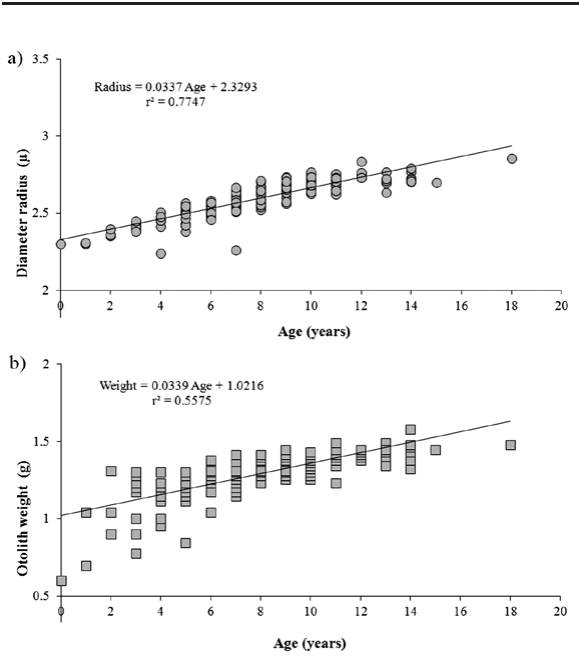
Fig. 5. – Relationships between the age and diameter (a) and weight (b) of otoliths.